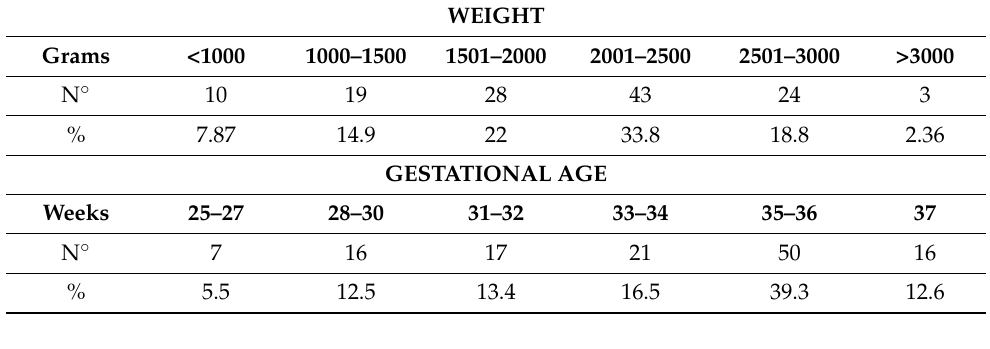
Figure 3. MAP, medically assisted procreation; CS, Caesarean section; MM, maternal milk. Ten (7.87%) newborns weighed < 1000 g (ELBW), 29 (22.8%) < 1500 g (VLBW), and Table 5. Weight and Gestational Age. 100 (78.7%) < 2500 g (Table 5, Figure 4). Table 5. Weight and Gestational Age.